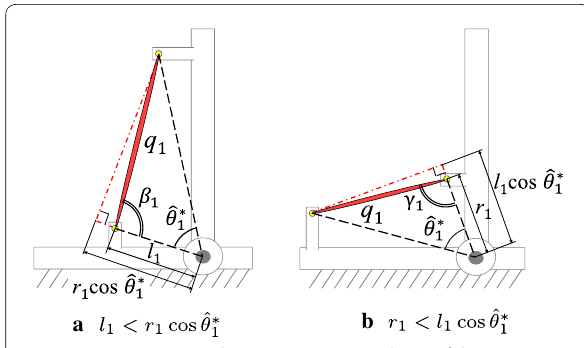
Fig. 6 Geometric muscular arrangement condition of the 1st simple-joint